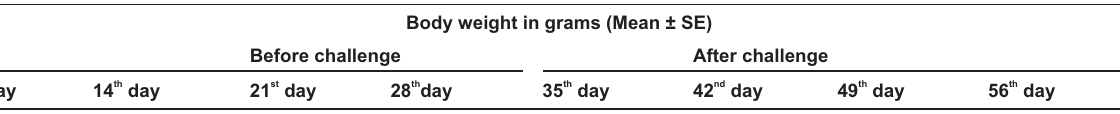
Table-2: Mean bodyweight gain in broiler chickens